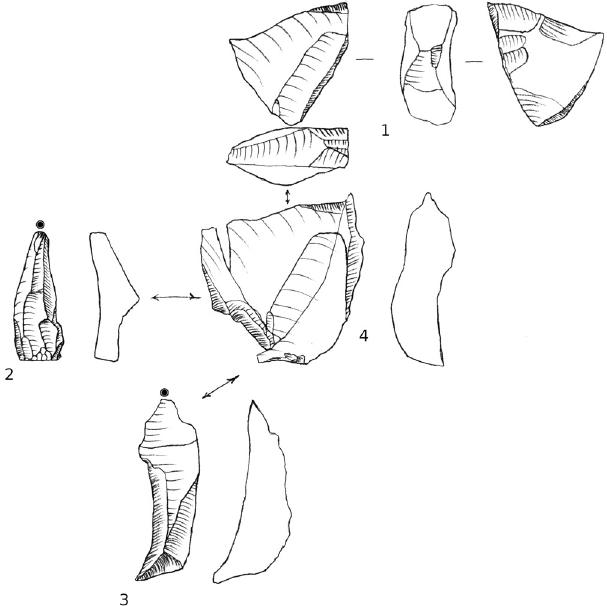
Figure 13: Re fi tting of “ Kukrek burin.